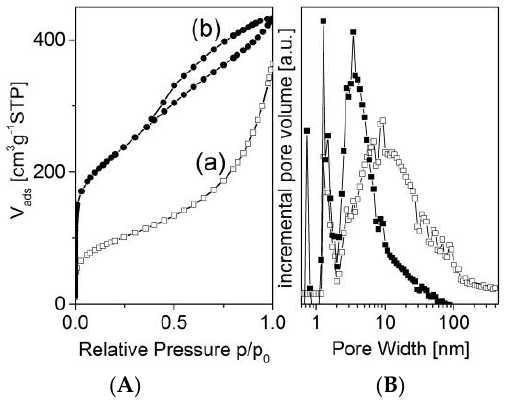
Figure 1. Carbon replicas and selected porous concrete-made template monoliths (one square of the pad corresponds to 10 mm).